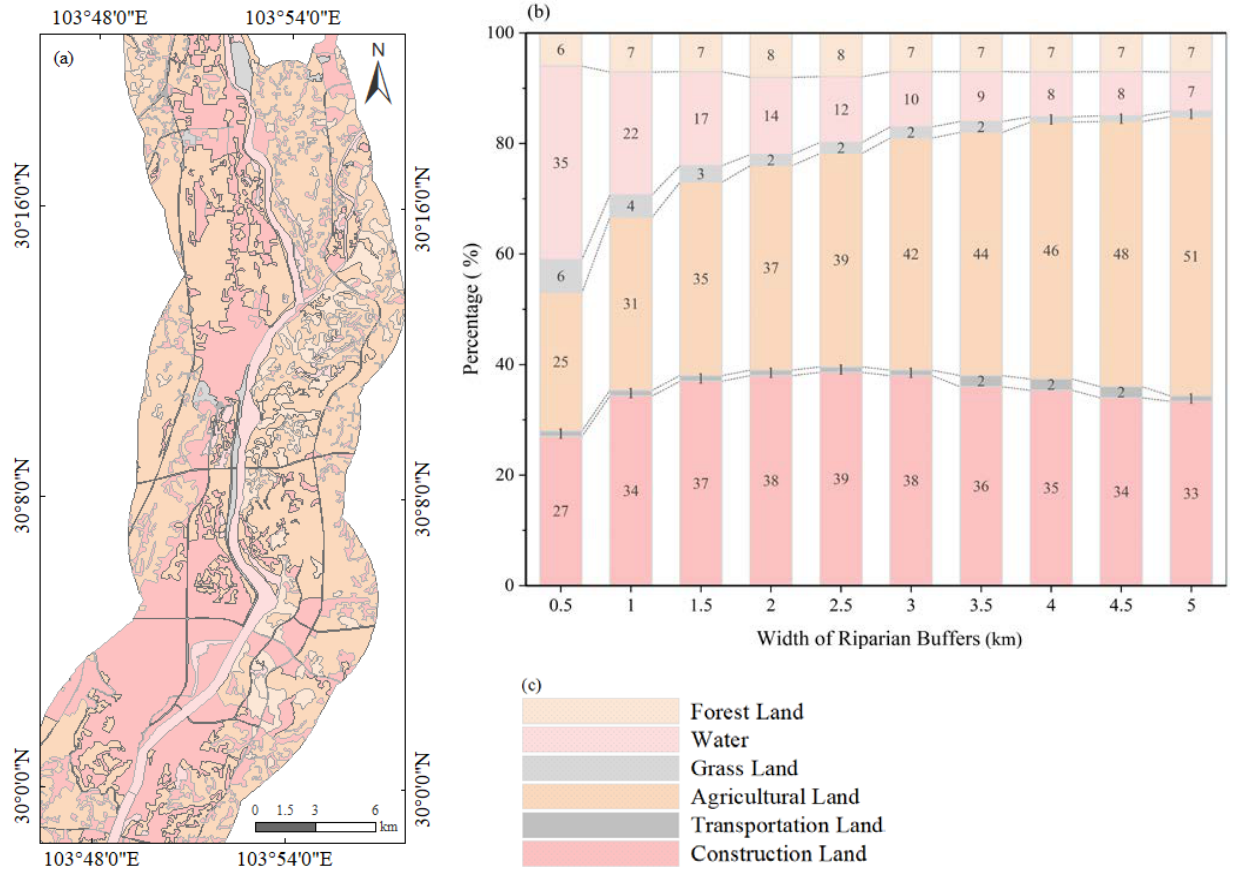
Figure 9. Riparian buffer-zone land use in the study area in 2018. Land-use map of the 5 km buffer zone along the main stream banks ( a ), different buffer-zone land-use types and percentages ( b ), land-use type legend ( c ) (percentages in ( b ), with the numerator being the area of each type of land and the denominator being the total area).